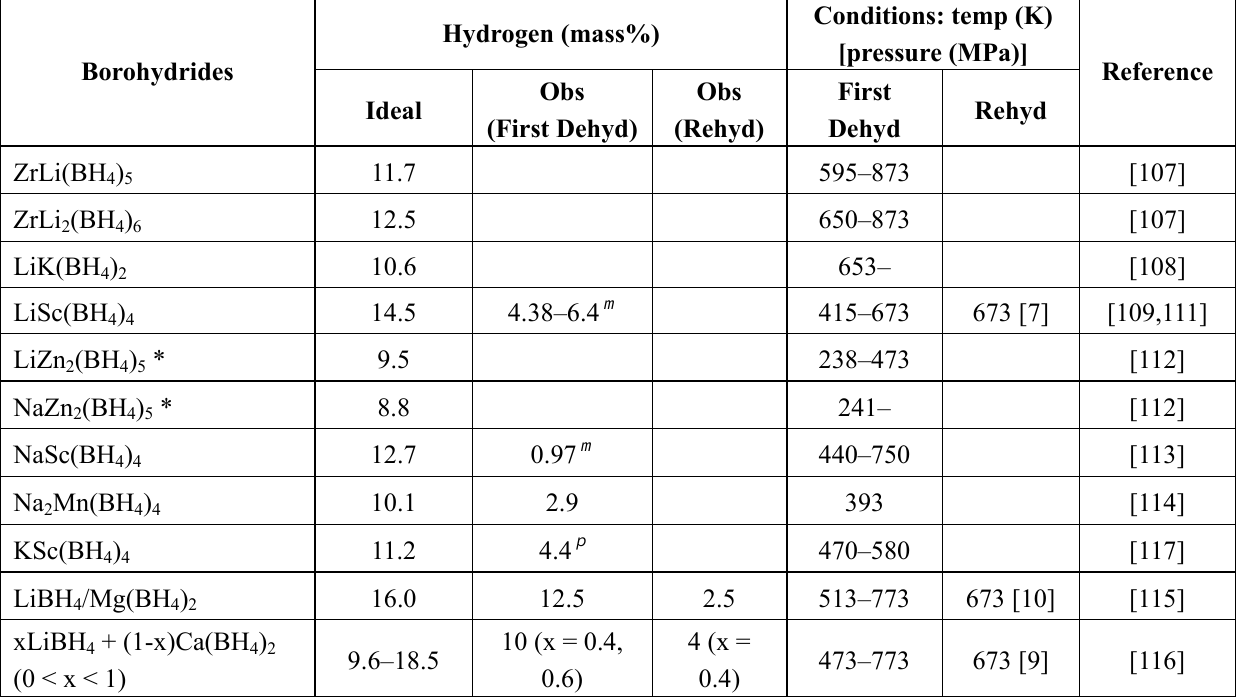
Table 2. Hydrogen storage properties of bimetallic borohydrides, MM’ (BH